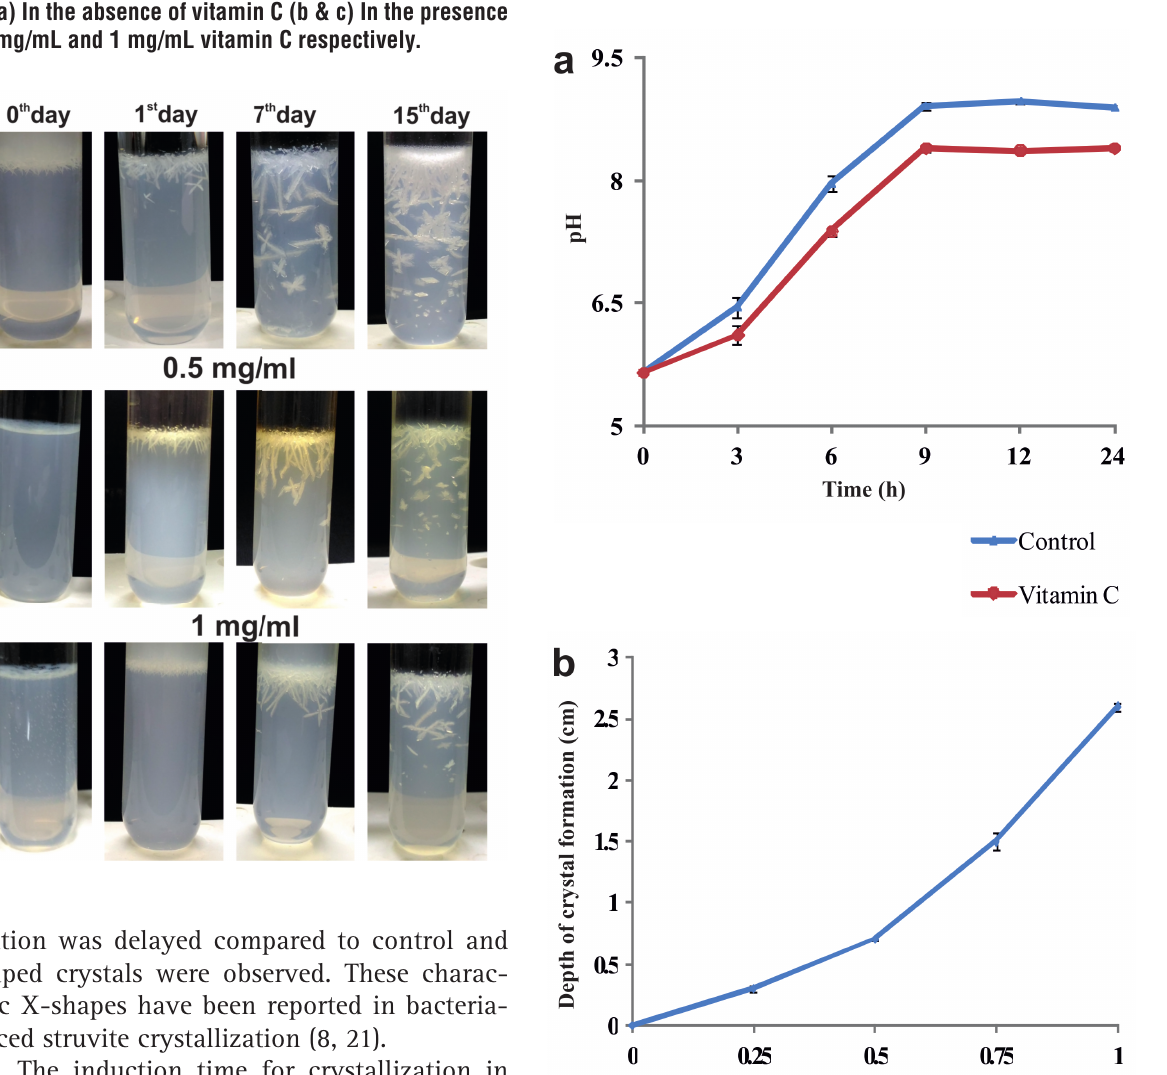
Figure 3 - a) Kinetics of pH of the artifi cial urine infected with Pseudomonas aeruginosa without (control) and with vitamin C. b) Depth of struvite crystals formed in the gel media in different concentration of vitamin